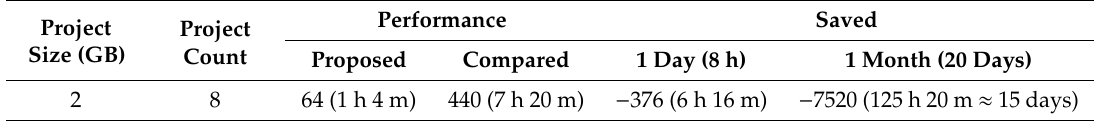
Table 8. Pipe object mapping performance comparison with manual process.